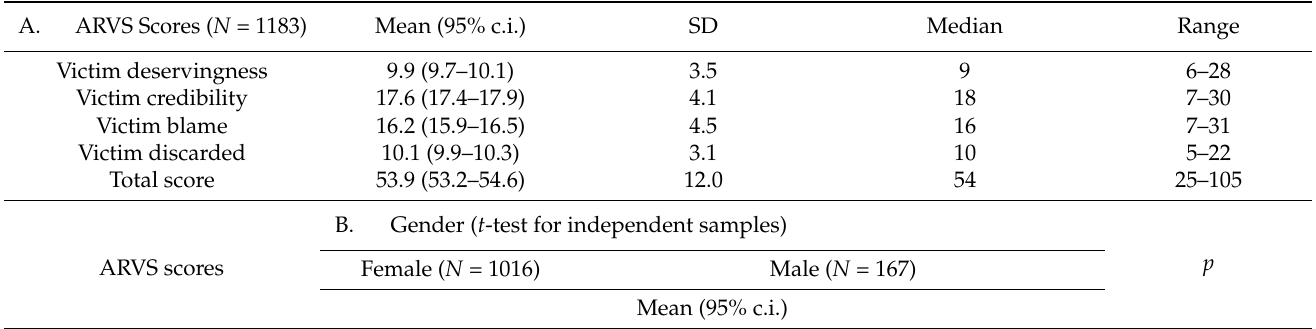
Table 2. ARVS scores in the entire study